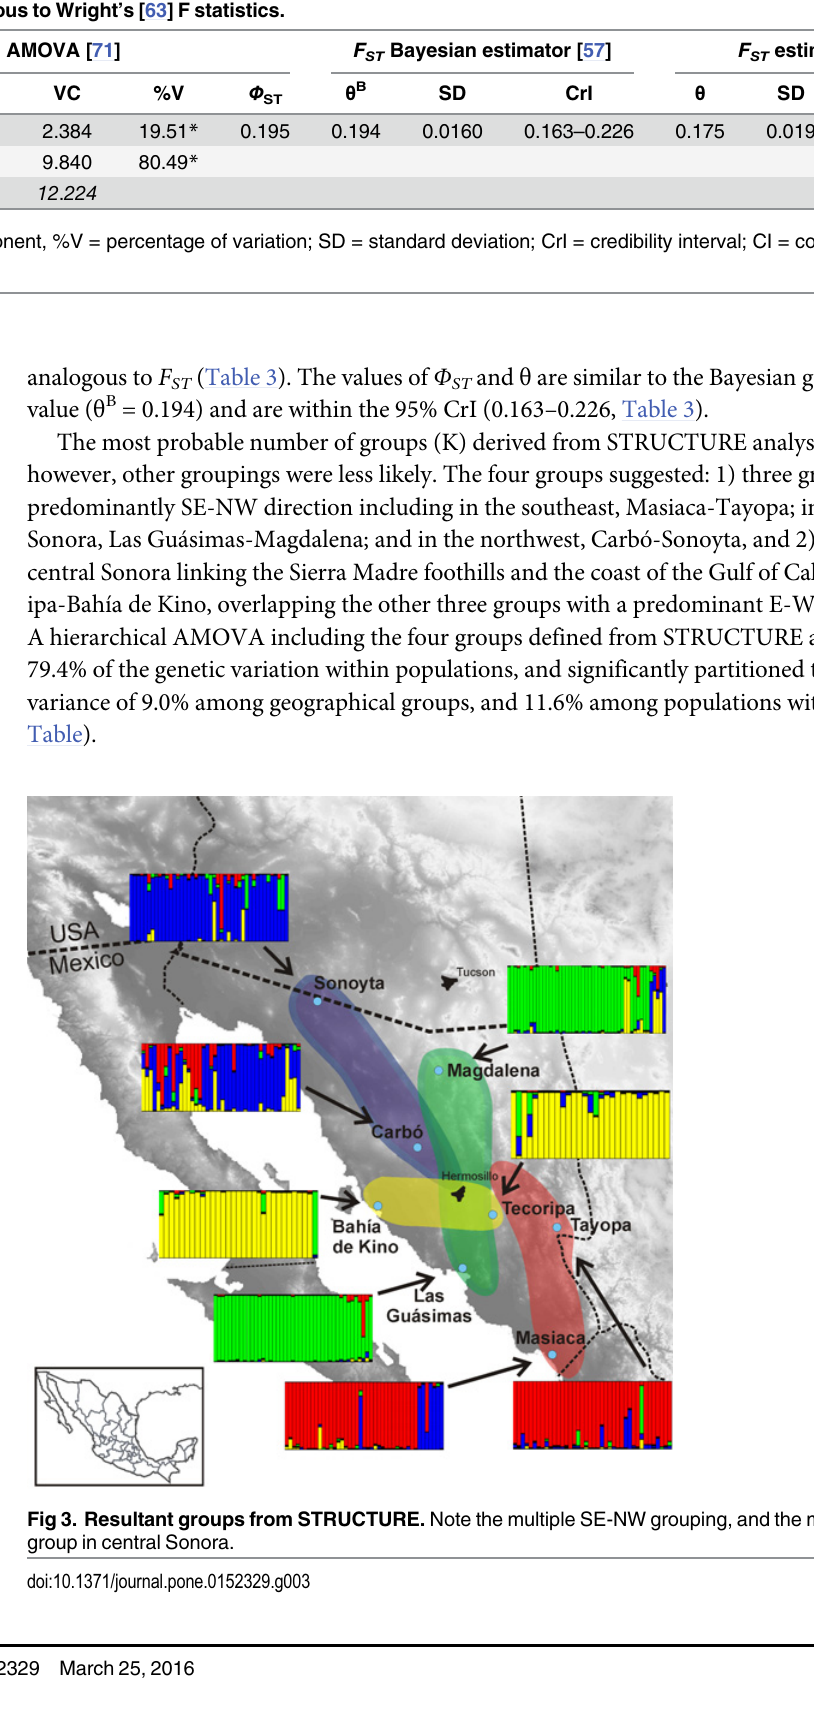
Table 3. Summary of analysis of molecular variance (AMOVA) performed with 99 loci ISSRs in eight populations of Stenocereus thurberi and genetic differentiation estimators analogous to Wright ’ s [63] F statistics.